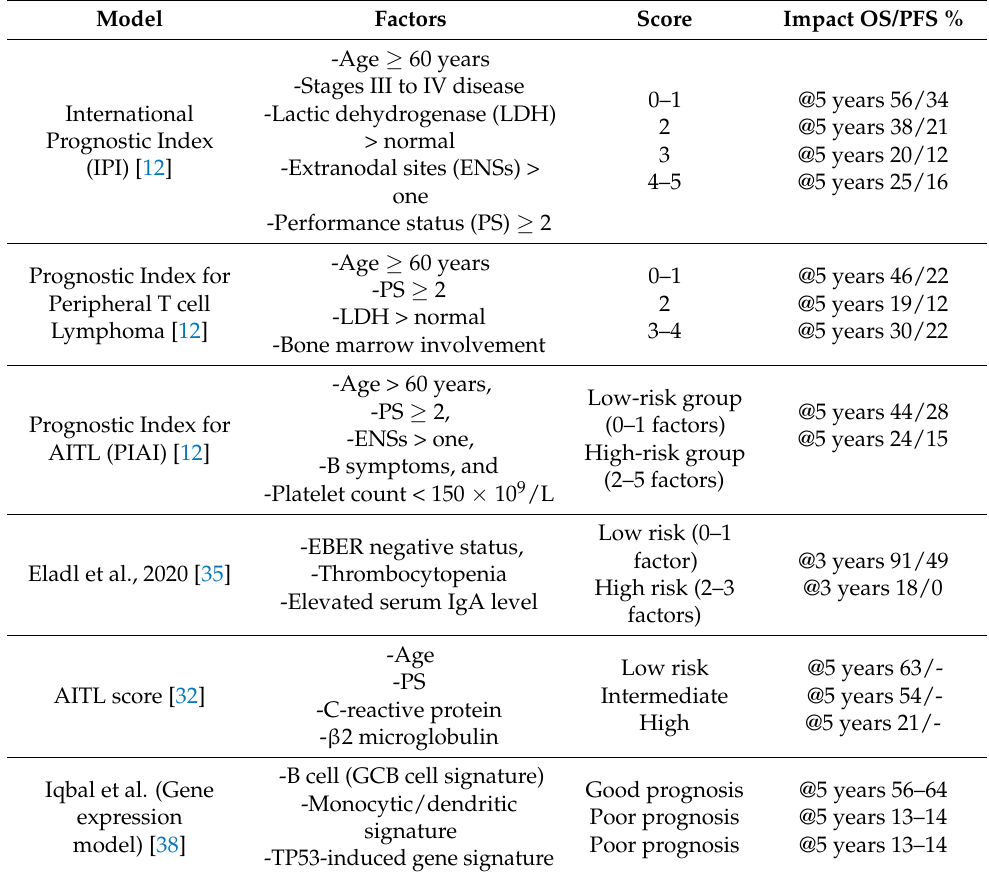
Table 1. Prognostic models and factors of